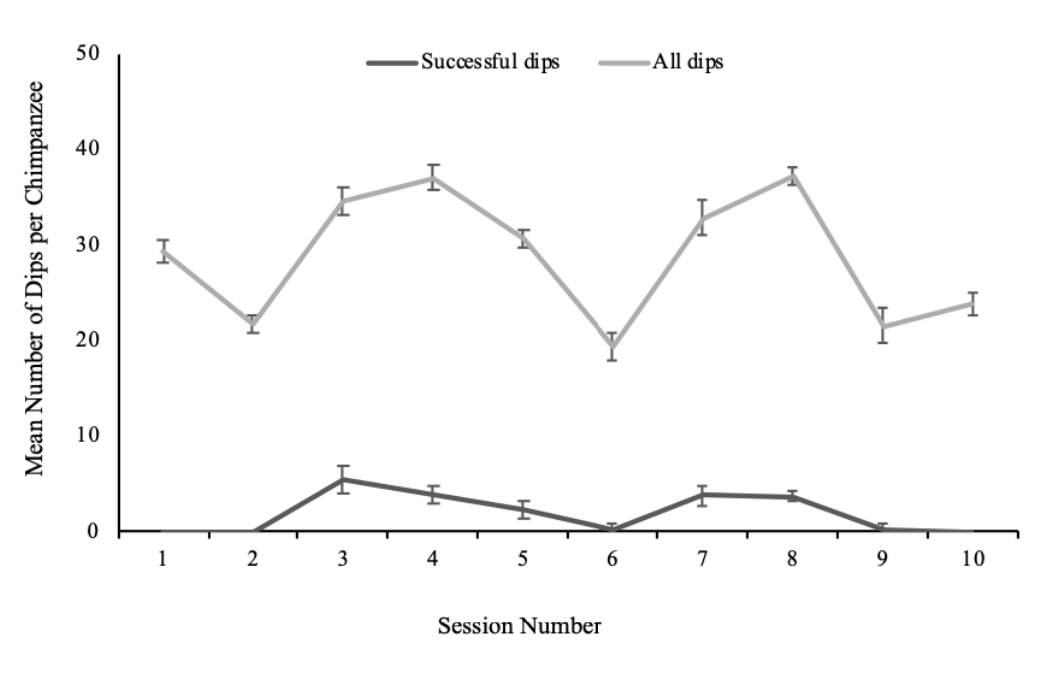
Individual Variation in Bouts, Sequences, Total Dips, and Success Within Sequences Proportion Total tool-set sequences